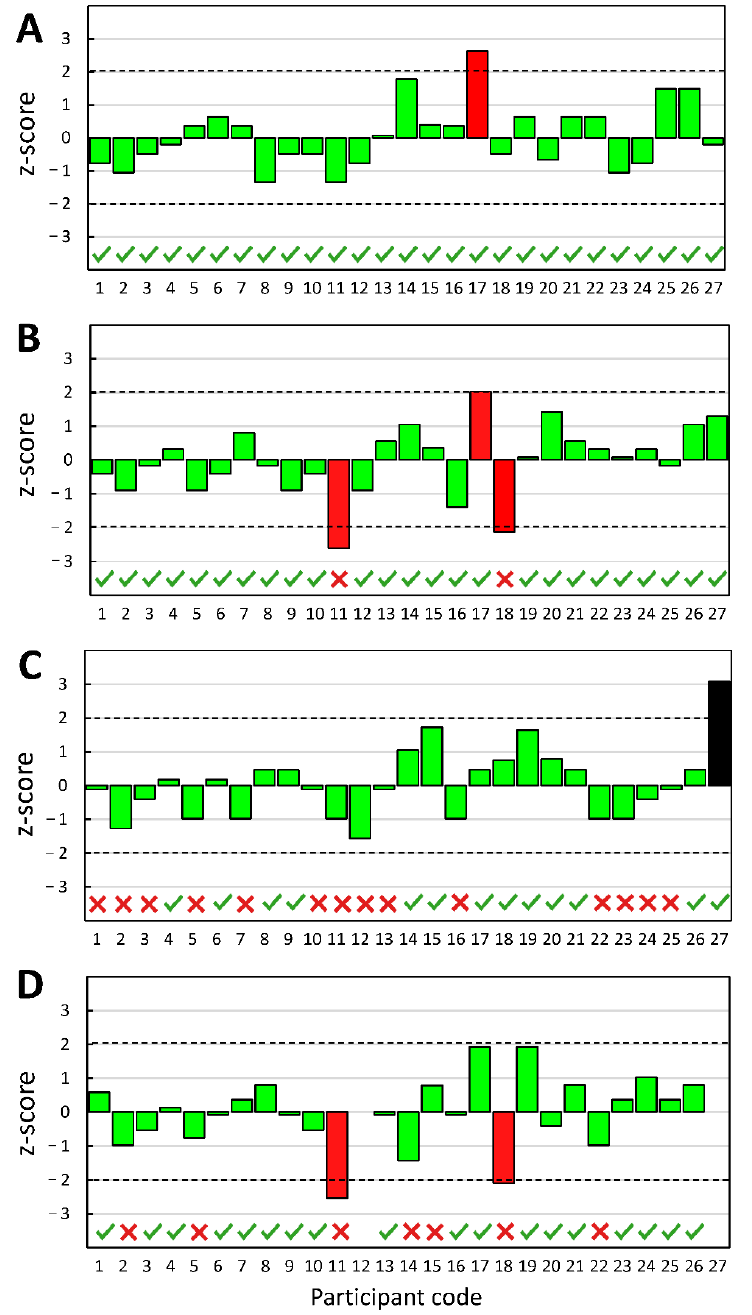
Figure 1. The results of the z-score analysis for measurements of the following CTA characteristics